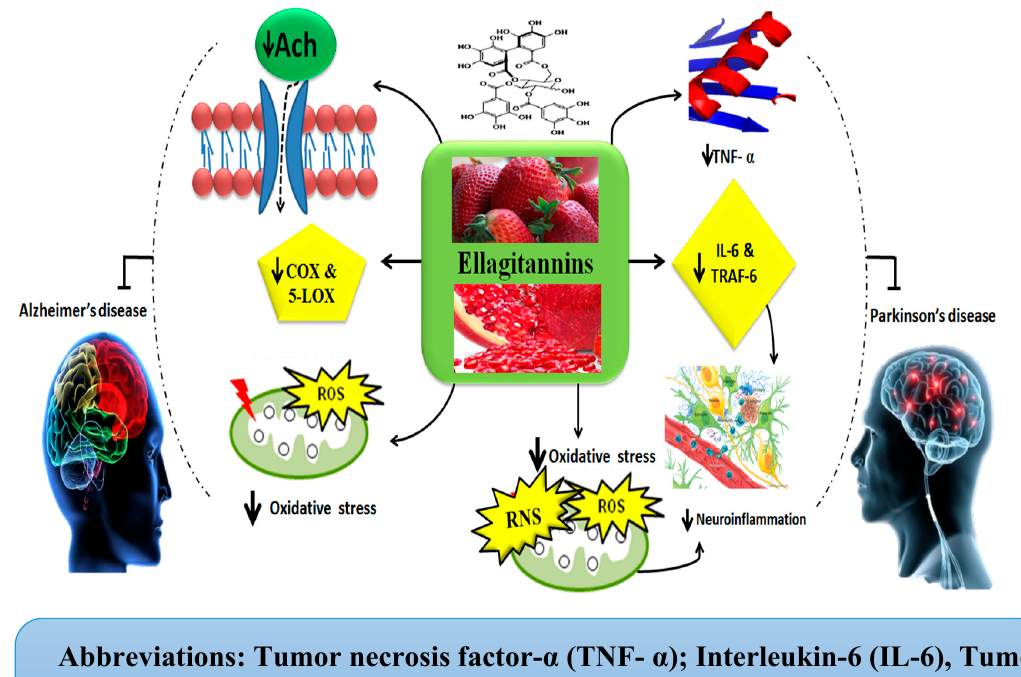
Figure 6. Ellagitannins in Alzheimer’s and Parkinson’s diseases.